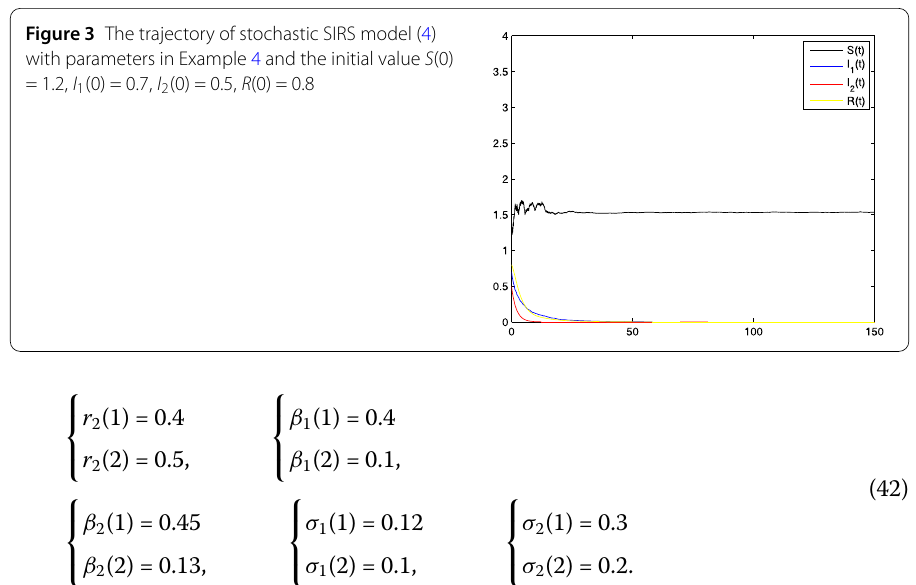
Figure 3 The trajectory of stochastic SIRS model (4) with parameters in Example 4 and the initial value S